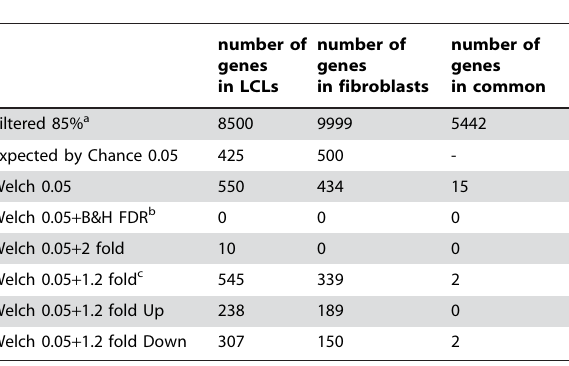
Table 2. Results of quality control, statistical, fold-change and overlap